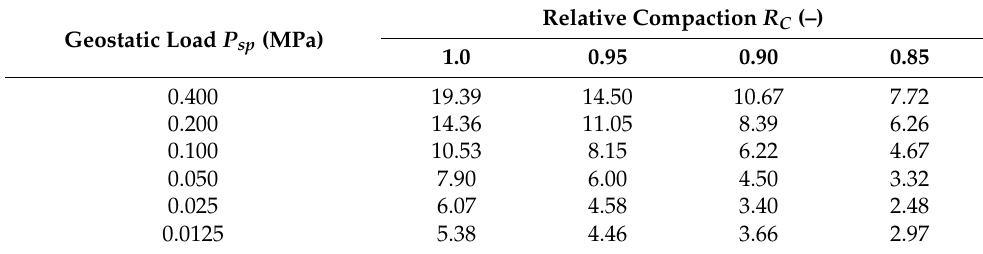
Table A3. Secant Constrained Recycled Asphalt Pavement (RAP) Modulus, E ode .